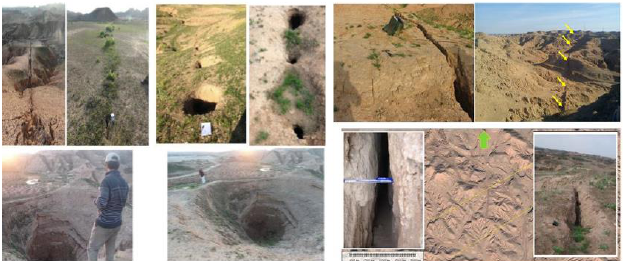
Figure 2. Sample of cracks observed in Azar Oil